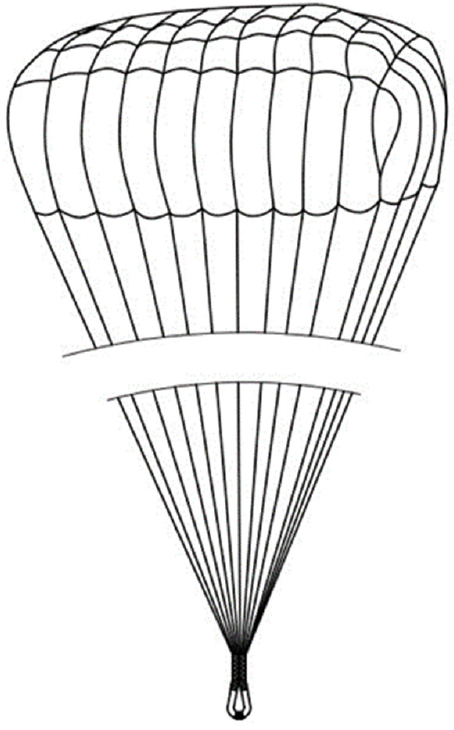
Figure 1. Parachute structure.